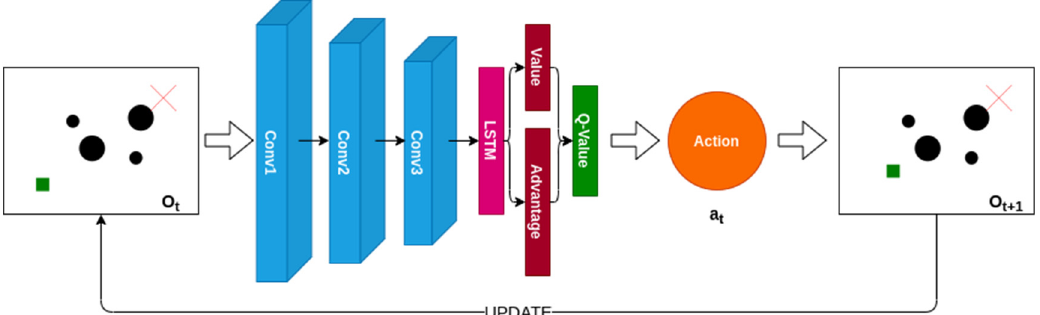
Figure 2. The architecture of the proposed global path planning method.